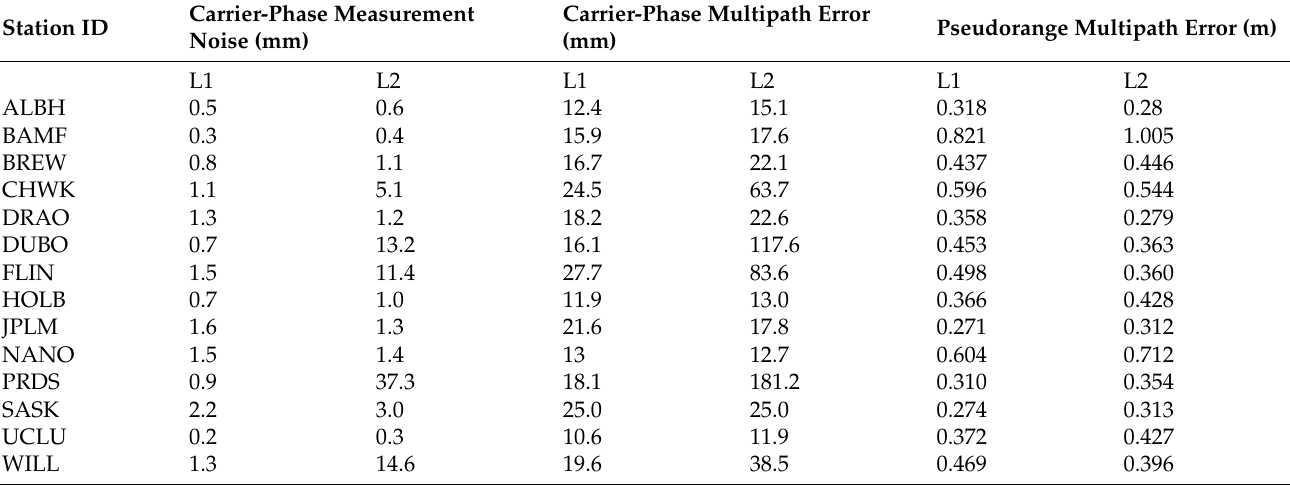
Table A17. Carrier-phase measurement noise, pseudorange, and carrier-phase multipath errors